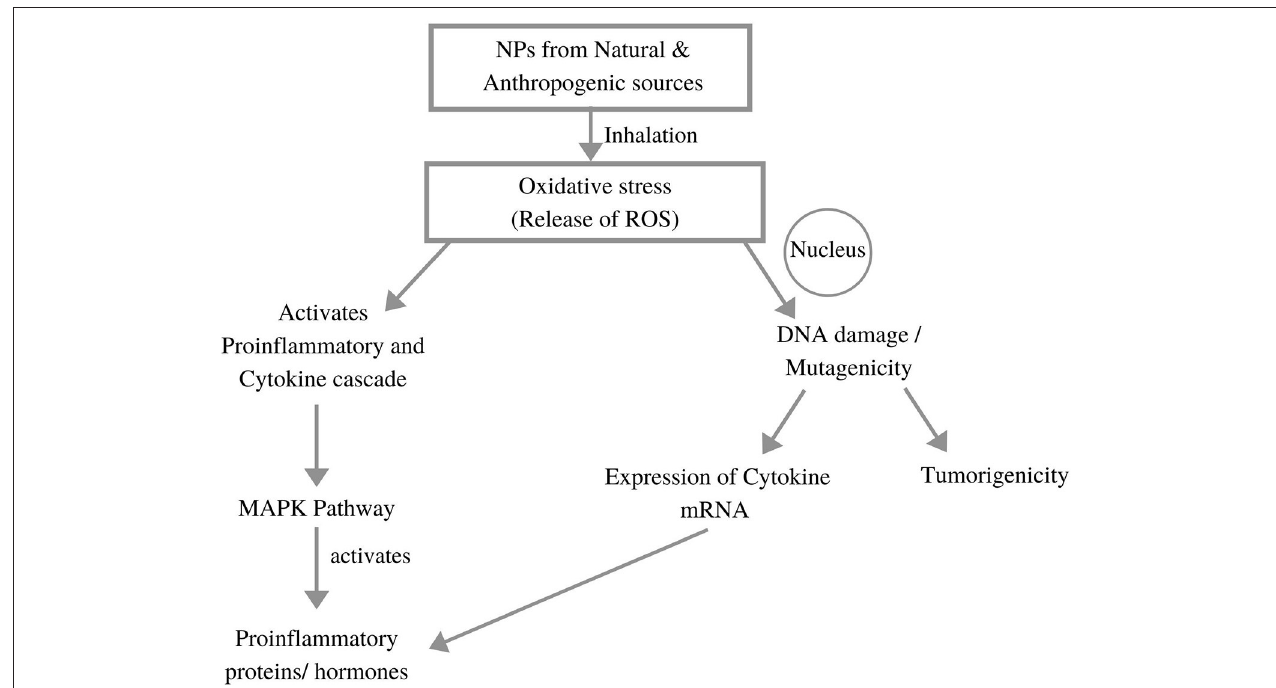
FIGURE 4 | Impacts of nanoparticle generated toxicity to the human body (adopted from Li et al., 2010; Chakraborty et al.,